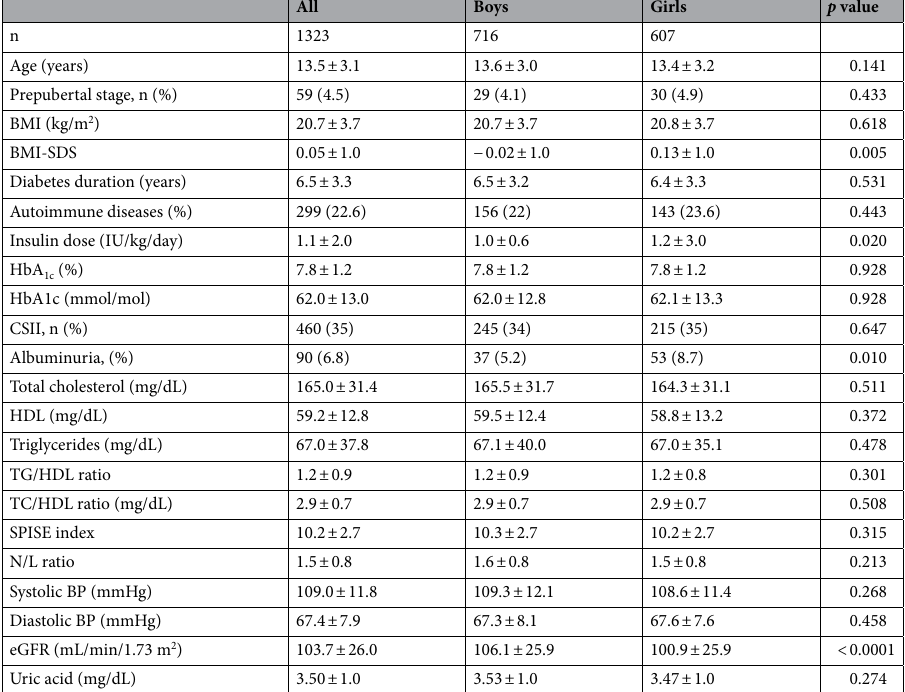
HbA 1c : glycosylated hemoglobin, CSII: continuous subcutaneous insulin infusion. MDI: multiple doses of insulin. IU/Kg/day: insulin dose pro Kg Day. TG/HDL ratio: triglycerides to HDL ratio. TC/HDL ratio: Cholesterol to HDL ratio. SPISE: single-point insulin sensitivity estimator N/L ratio: Neutrophil/Lymphocyte ratio. BP: blood pressure. eGFR: estimated glomerular filtration